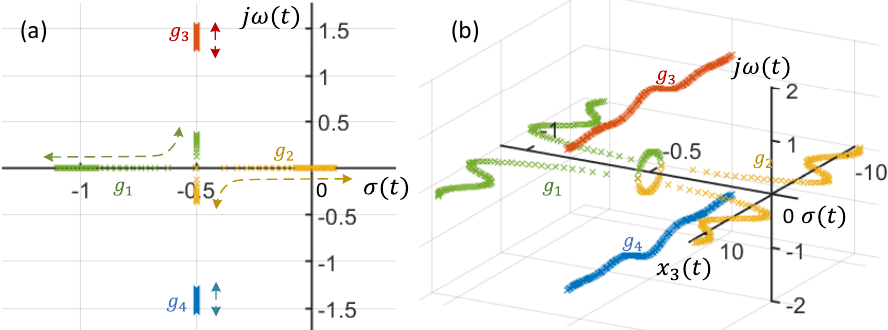
Mostly, the poles are on the left-hand plane (LHP) in the g -plane, which represents stable states of the system. However, at some x 3 ( t ) values, one ( g 2 ) of the dynamic poles crosses over the imaginary axis to RHP, which implies unstable states of the system, and a proper a proper controller is necessary for this hybrid soft leg. controller is necessary for this hybrid soft leg.